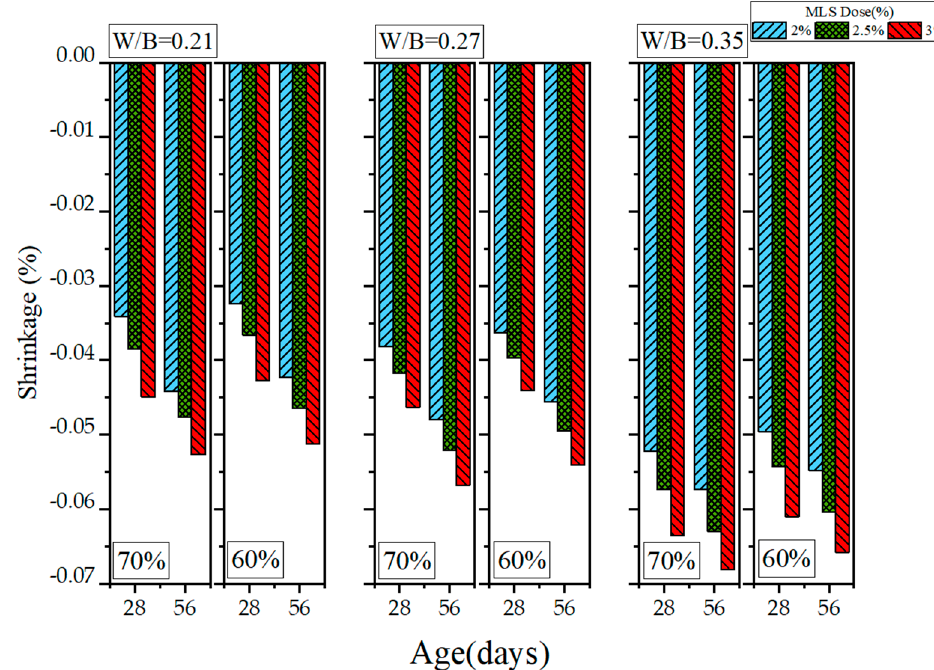
Figure 21. Length changes of green and ecofriendly grouting material with MLS.